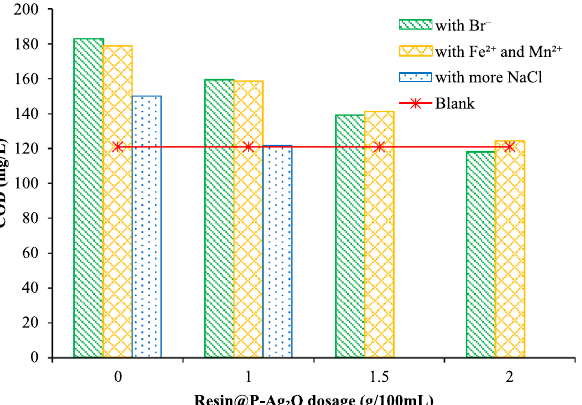
Figure 10. Effect of resin@P-Ag 2 O dosage on the COD measurement of 120 mgO 2 /L KHP standard solution: blank (without any salt and resin@P-Ag 2 O), with Br − (1000 mg NaCl/L + 1000 mg NaBr/L), with Fe 2+ and Mn 2+